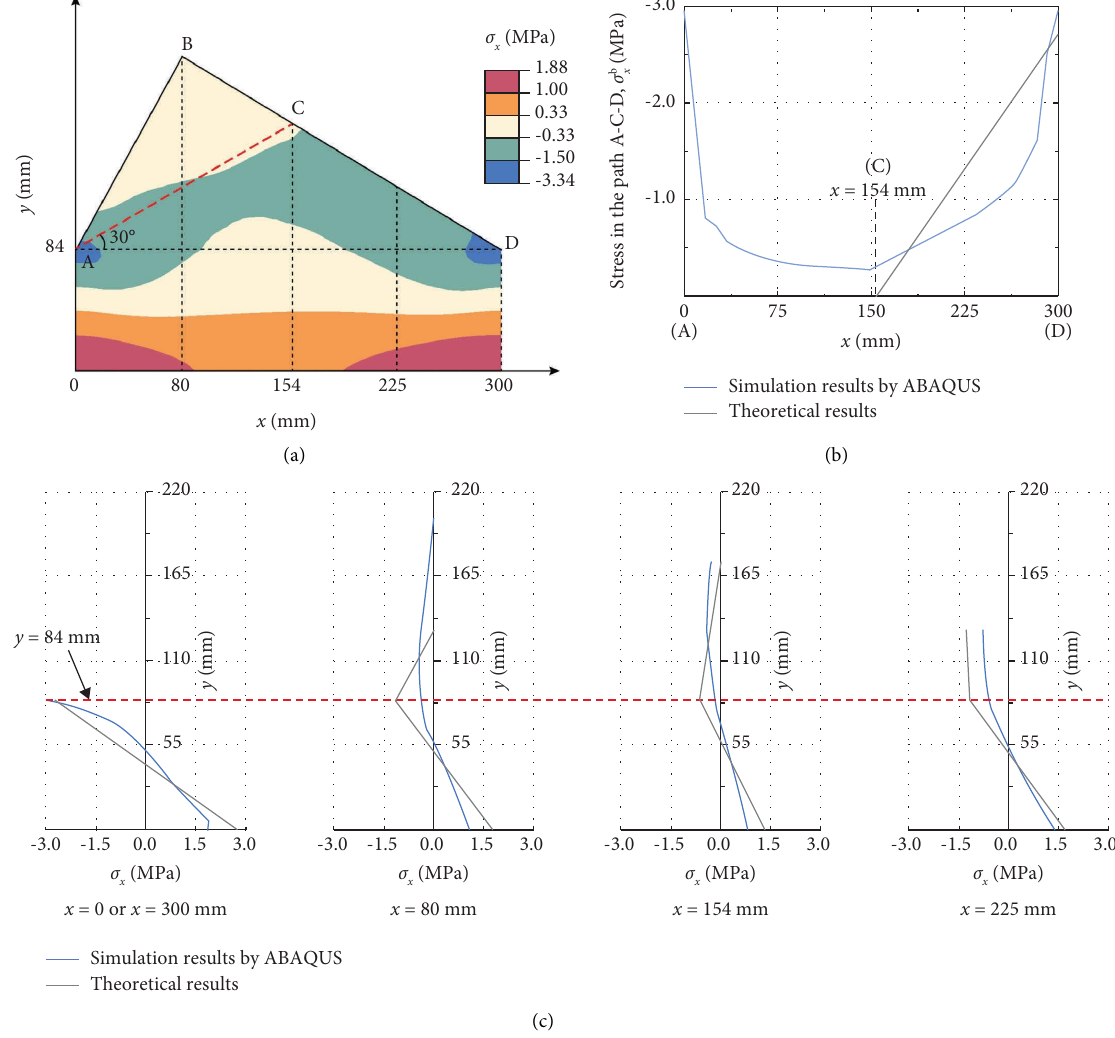
Figure 7: Te normal stress distributions due to gravity in the simulation results and the theoretical results for the unit cell at midspan of the stair slab with t � 84mm. (a) Te stress contour in the simulation results. (b) Comparison of the stresses in the path A–C-D. (c) Comparison of the stresses at x � 0 or 300, 80, 154, and 225